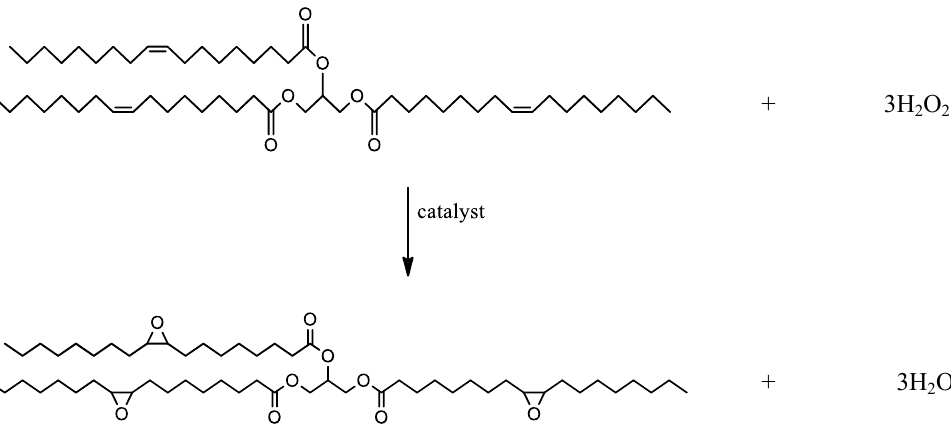
Figure 2 . Epoxidation reaction with hydrogen peroxide as oxidant.